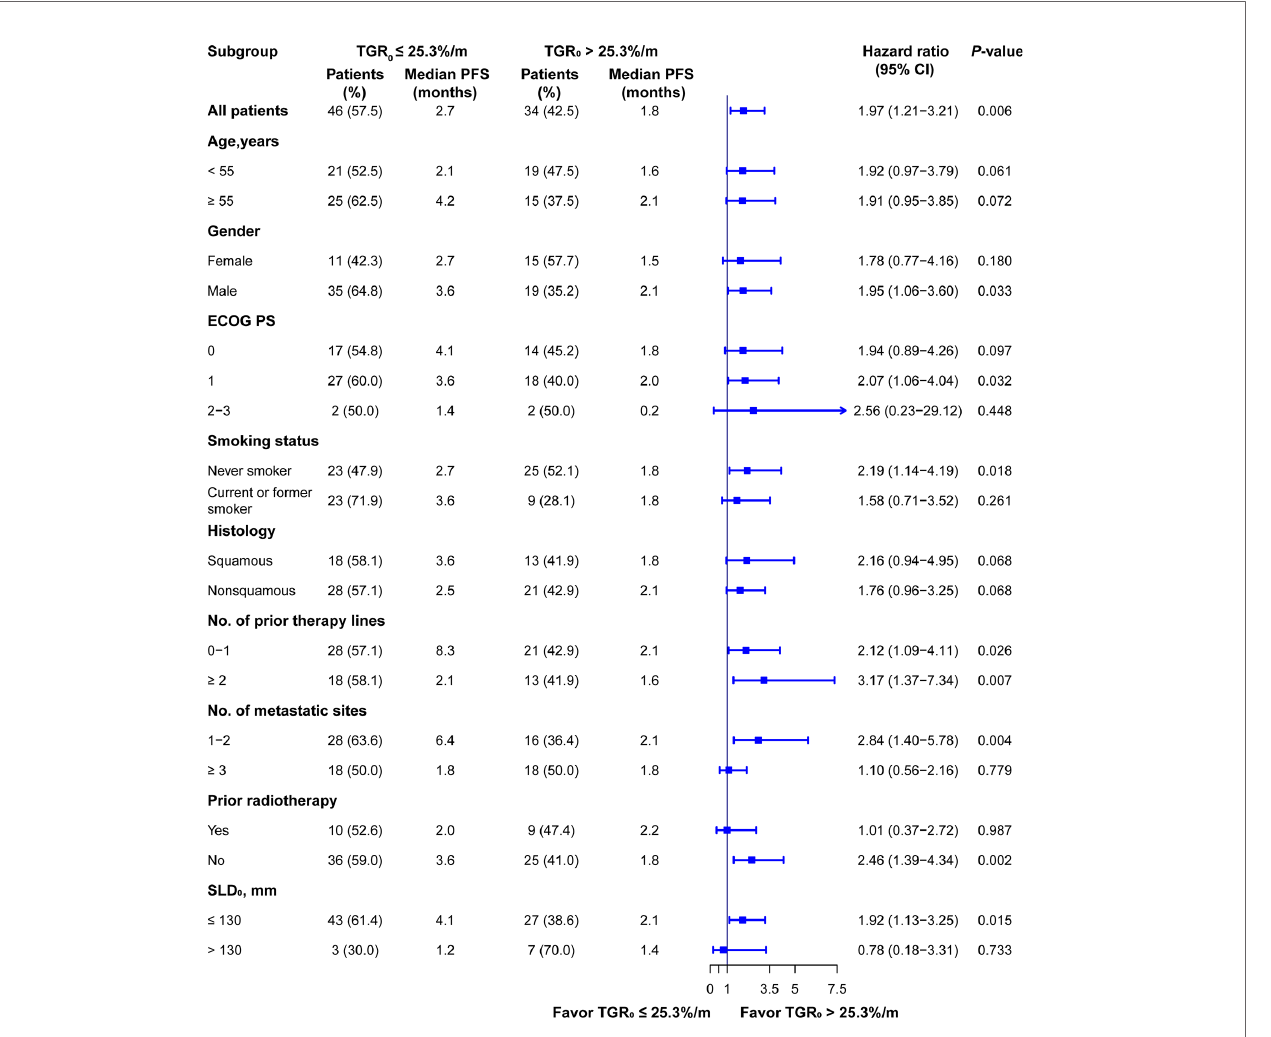
FIGURE 5 | Subgroup analysis of PFS according to TGR 0 strati fi cation. Findings were examined by Cox proportional hazard regression